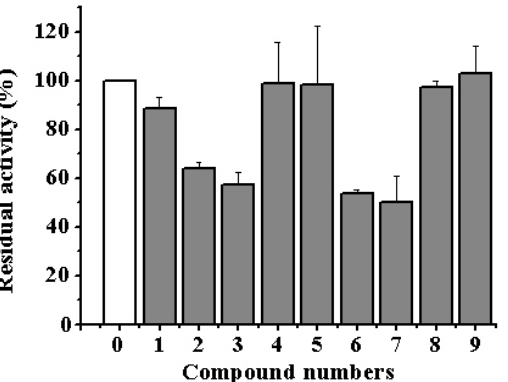
Figure 1. Residual activity of lysate cell α -NaGalase after treatment of colon cancer cells DLD-1 with 5 μ M of aaptamine ( 1 ), isoaaptamine ( 2 ), 9-demethylaaptamine ( 3 ), aaptanone ( 4 ), damirone A ( 5 ), damirone B ( 6 ), makaluvamine H ( 7 ), makaluvamine G ( 8 ), zyzzyanone A ( 9 ) relative to the enzyme of untreated cells as positive control ( 0 ). Residual activity of α -NaGalase was defined as A/A 0 × 100 (%), where A and A 0 are the specific activities of α -NaGalase of the samples ( 1 – 9 ) and the control experiment ( 0 ), respectively. Data are shown as means ± standard deviation (SD) of values from three independent experiments ( p < 0.05) evaluated by methods of descriptive statis- tics in software “Origin